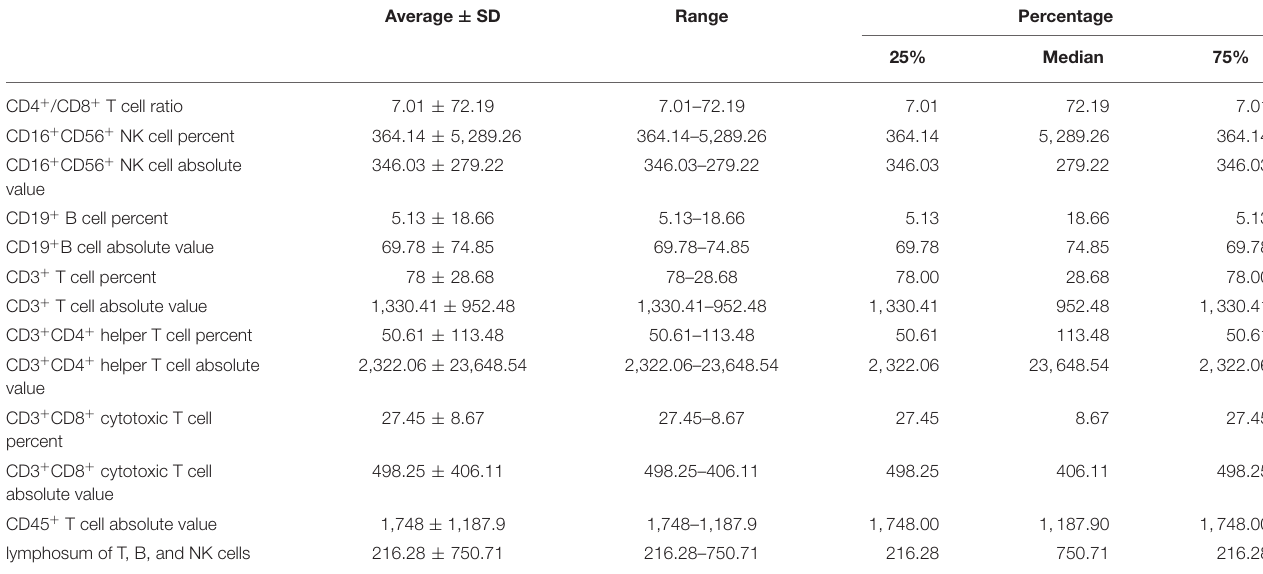
TABLE 3 | Statistical distribution of immune function indexes after